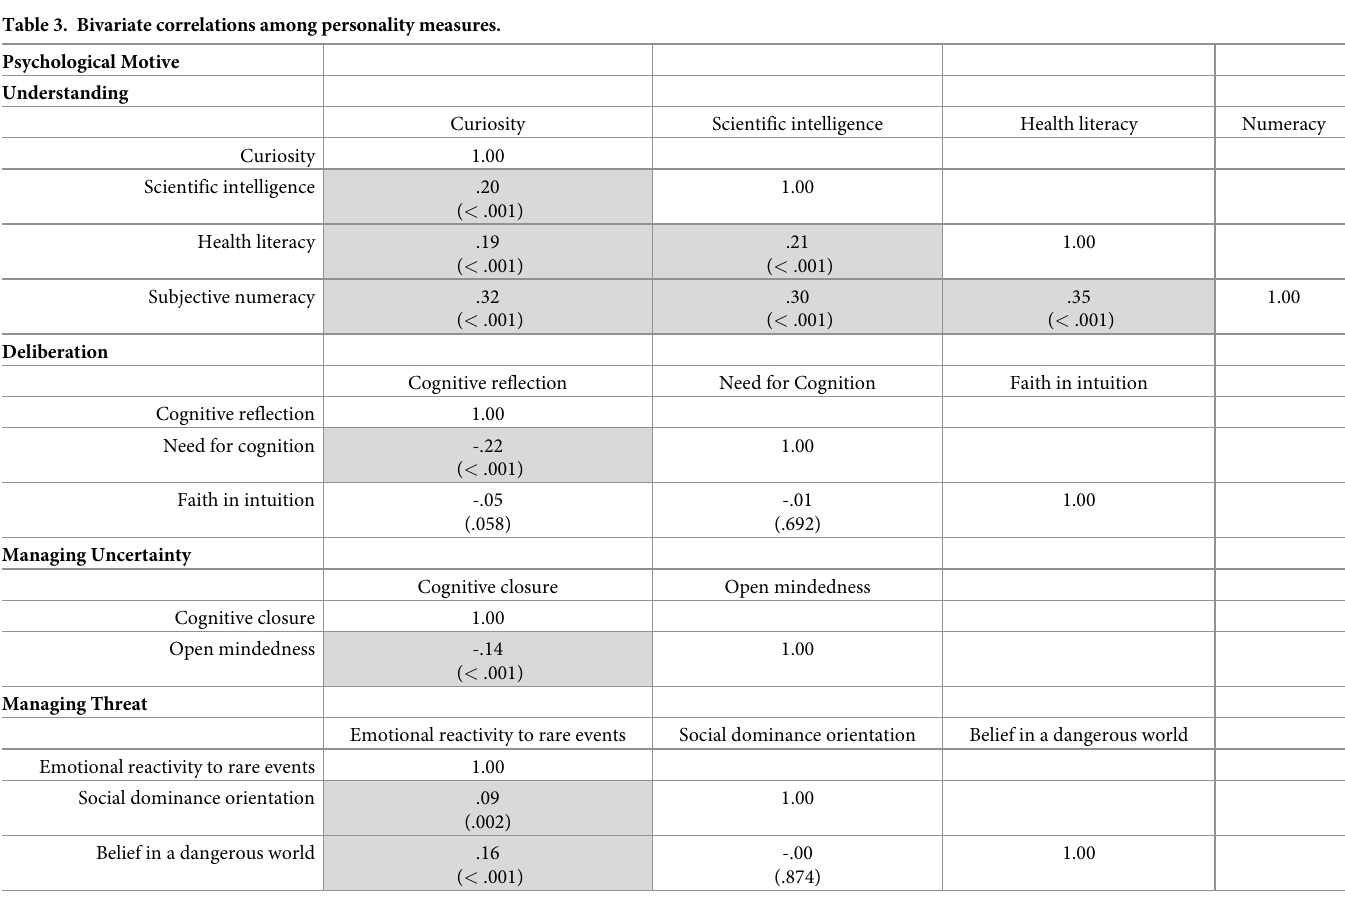
Table 3. Bivariate correlations among personality